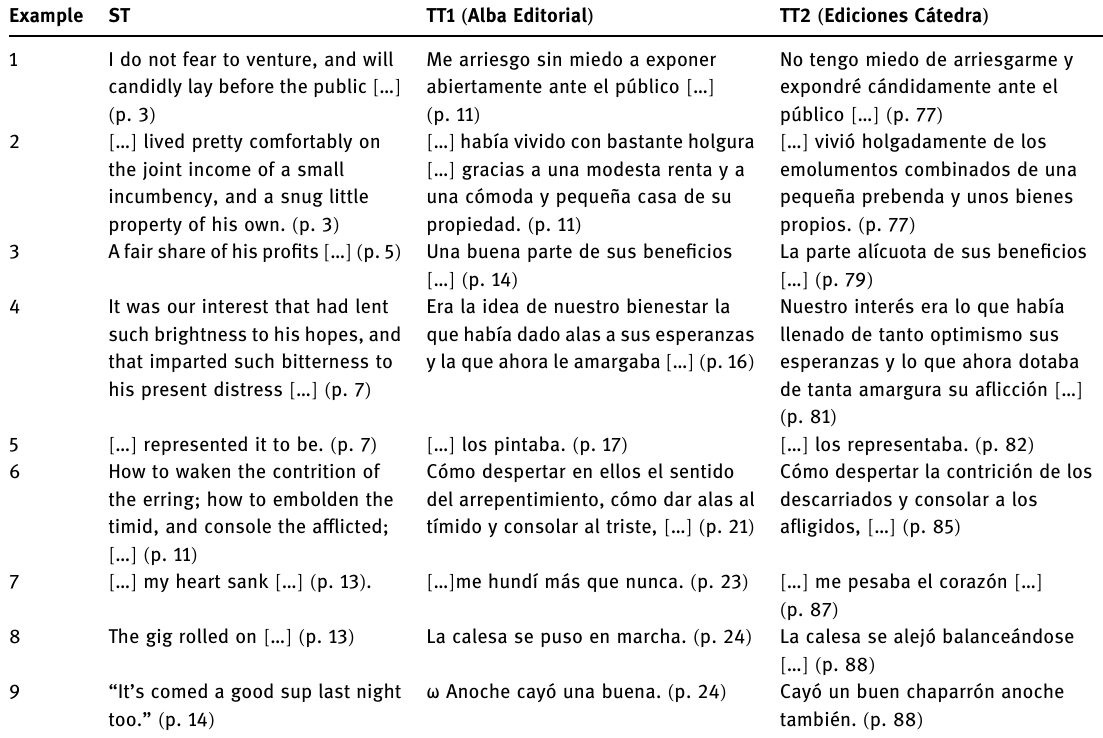
Table 1: Examples taken from Chapter